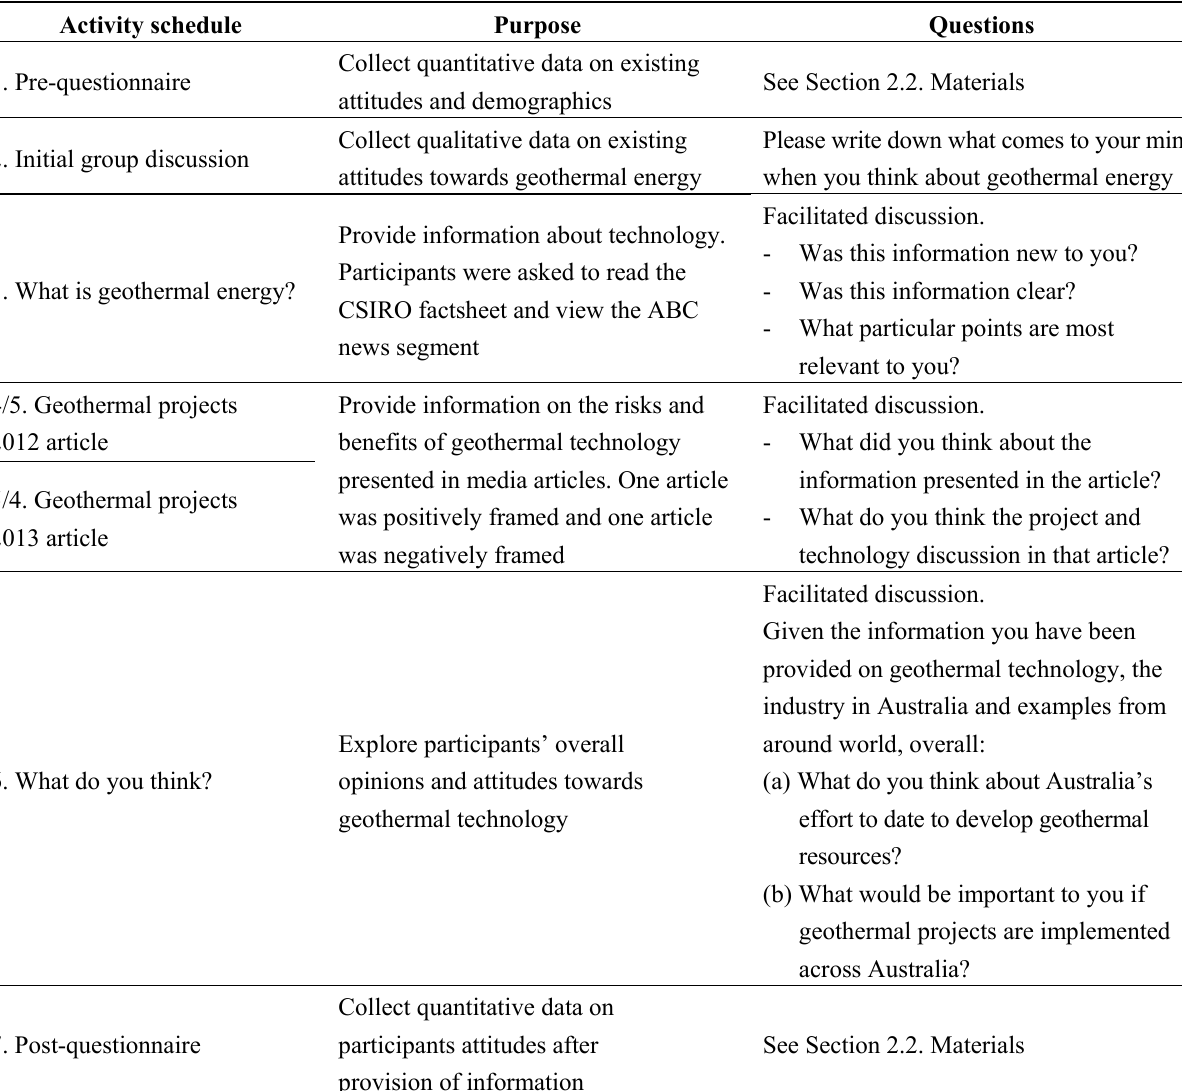
Table 1. Online focus group activities, including information provided and discussion